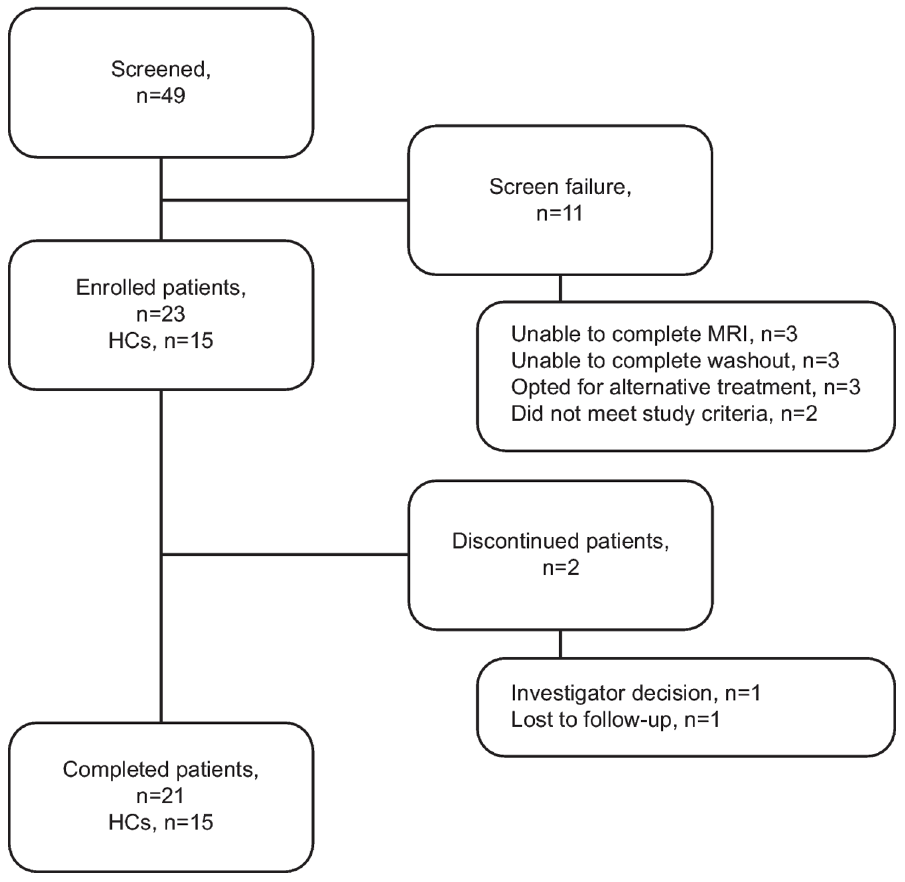
Figure 1. Subject numbers from enrollment to study completion. HC, healthy control; MRI, magnetic resonance imaging.